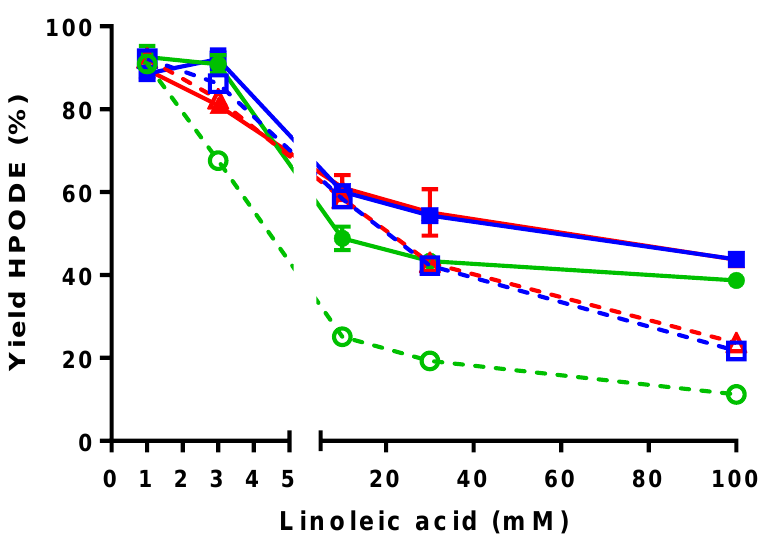
Figure 2. HPODE yield as a function of substrate concentration and enzyme–substrate ratio in the presence of 3% Triton-CG 110 ( v / v substrate) with 20,000 U/mmol ( , ), 100,000 U/mmol ( , ) and 200,000 U/mmol ( (cid:52) , (cid:78) ) LOX, filled symbols: in presence of Triton-CG 110, open symbols and dotted line: without addition of surfactant.